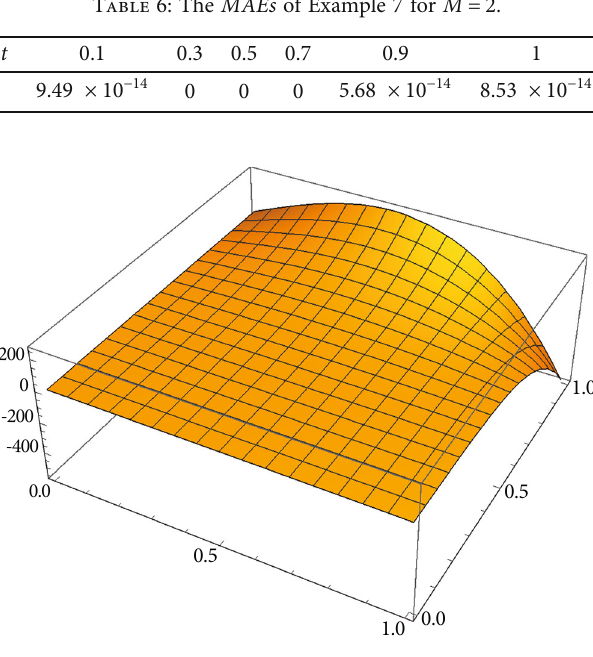
Figure 7: Exact solution for Example 7.